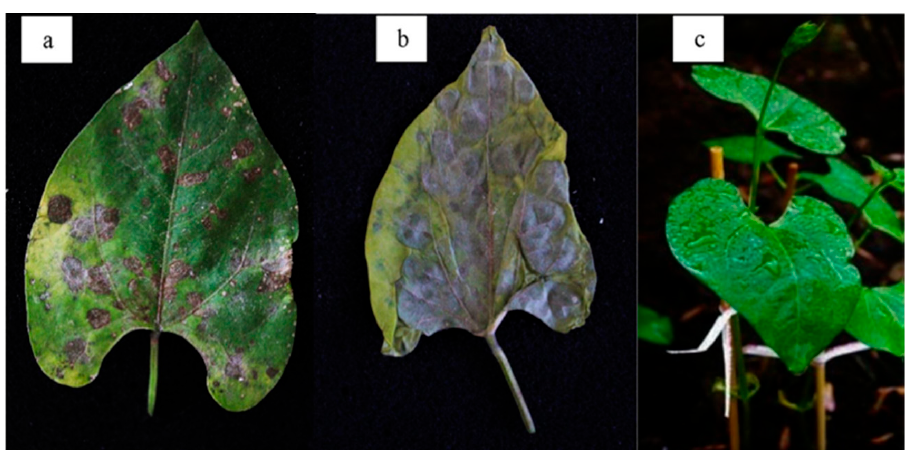
Figure 2. Pathogenicity tests with strain Xcf1-APJR: ( a ) Leaf of P. vulgaris with necrotic foliar stain and chlorotic halo at 7 days after inoculation; ( b ) wilting and total necrosis of foliar tissue at 14 days; ( c ) control group without symptoms.